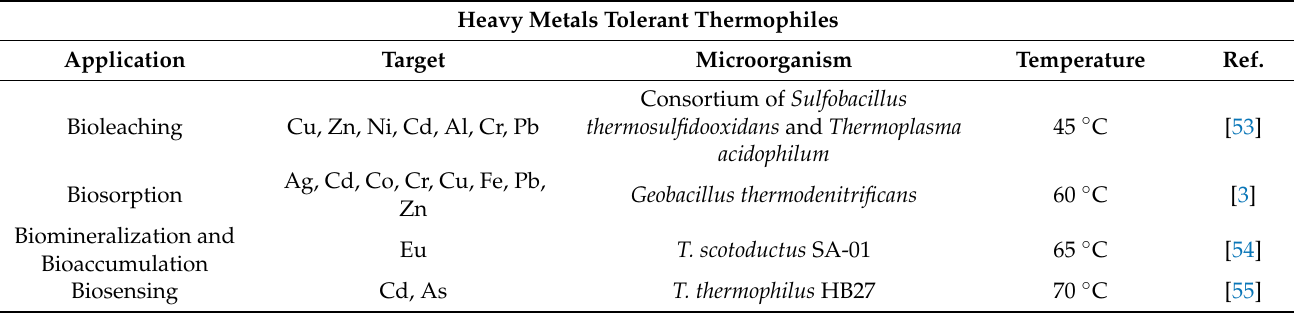
Figure 2. Schematic representation of metal bioprocesses in biometallurgy. Metals (blue circles) can be extracted from ores through biomining/bioleaching (green arrow) and they can be recovered into the cell by passive import (biosorption—blue arrow) or energy driven transport (bioaccumulation—red arrow). Table 1. Examples of thermophiles exploited in